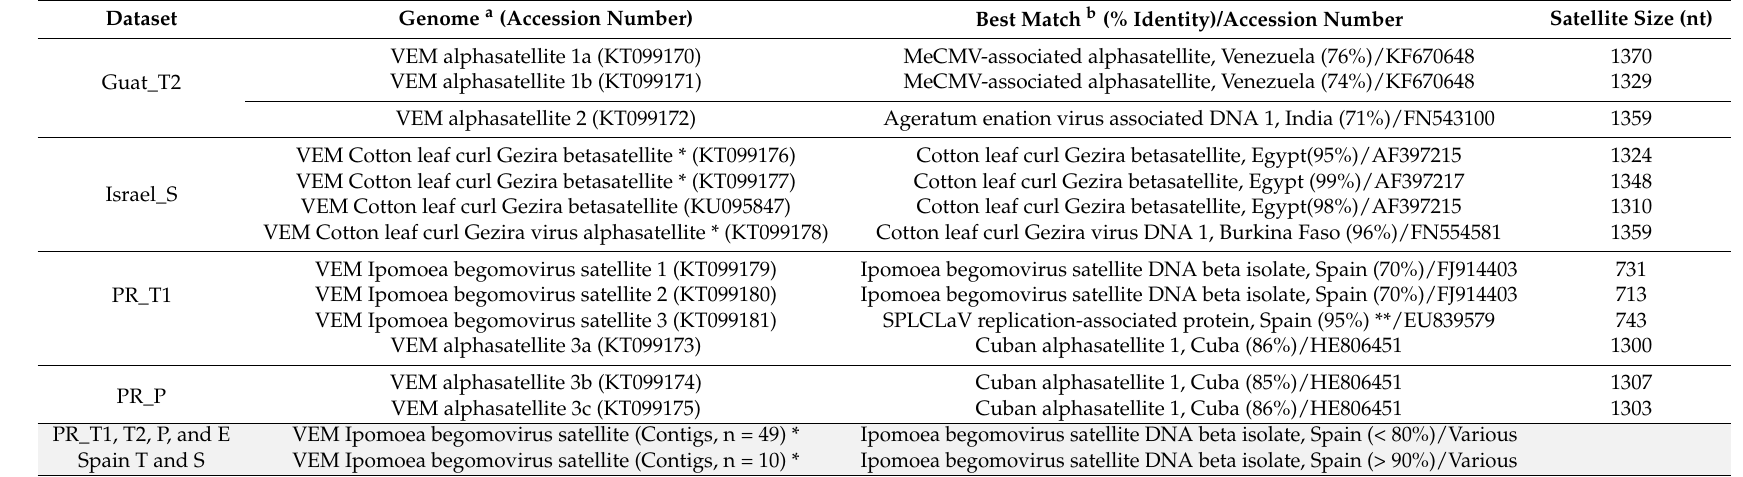
Table 2. Satellite DNA molecules detected in